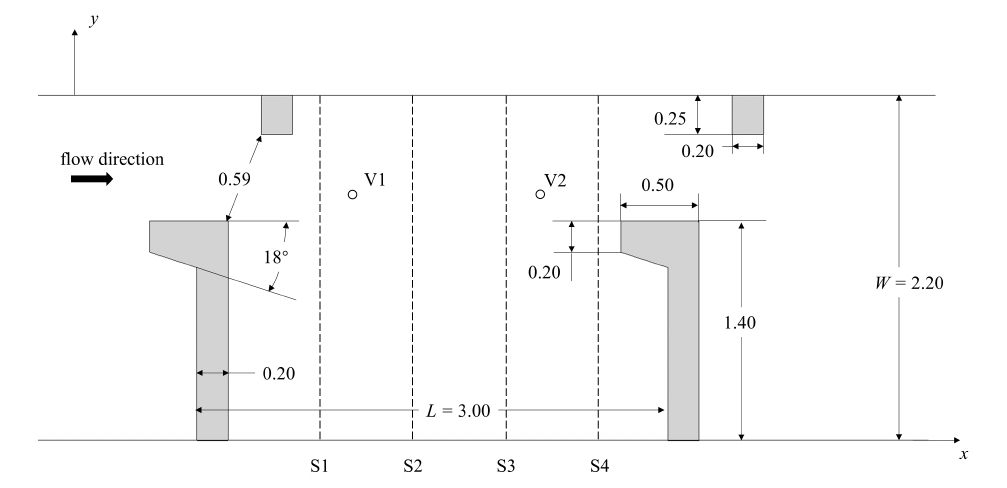
Figure 1. Plane layout for the selected pool of the VSF with geometric parameters. V1 and V2 are two ADV gauging points. S1 to S4 denote the four sampling